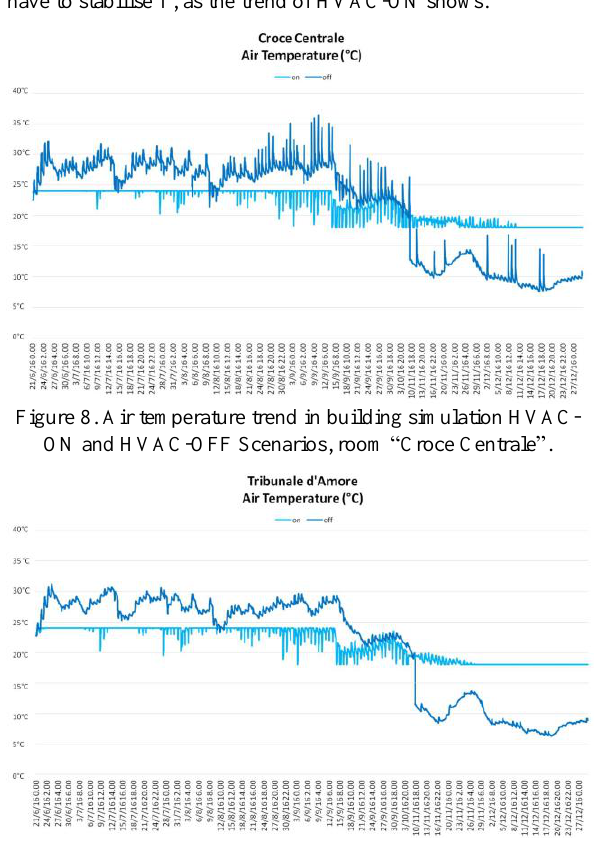
Figure 9. Air temperature trend in building simulation HVAC ON and HVAC-OFF Scenarios, room “Tribunale D’Amore”.